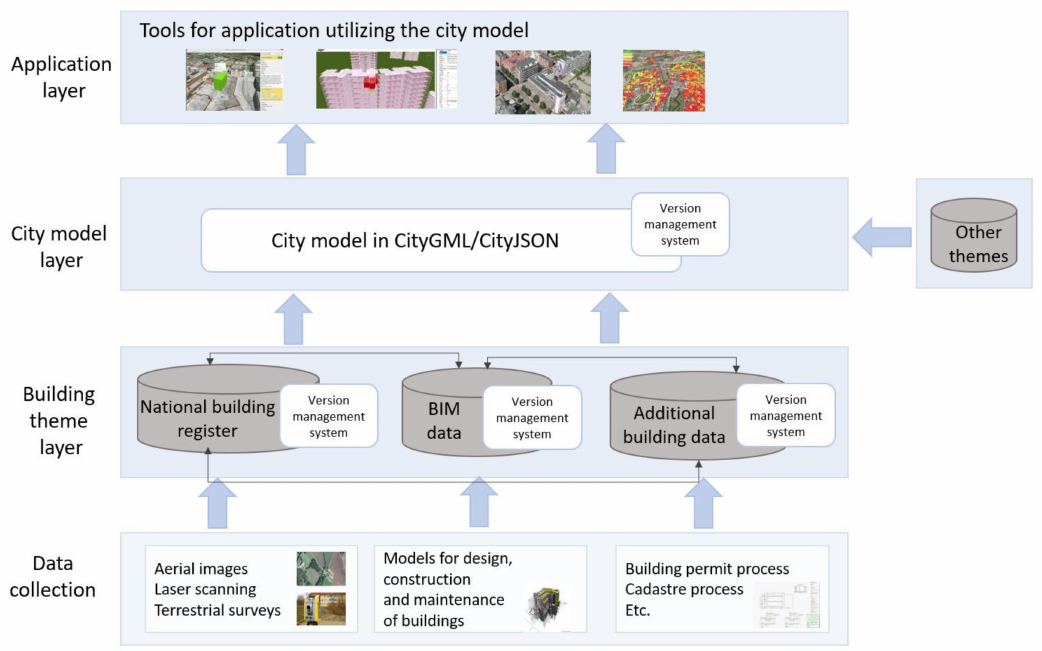
Figure 1. Overview of an architectural model for the provision of 3D city model